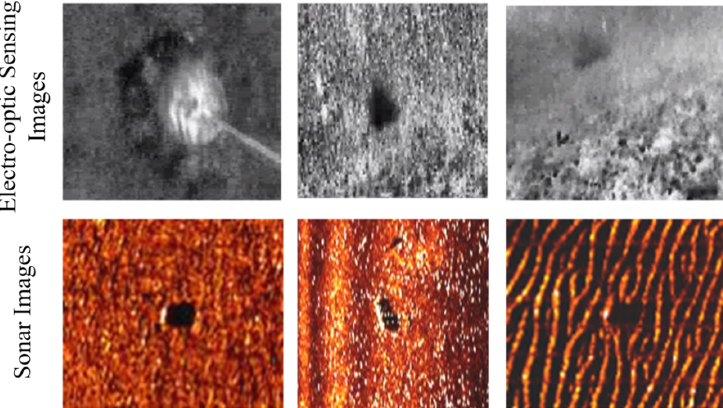
Figure 16. Mine images with variable environmental noises from electro-optic sensors and sonars [146].